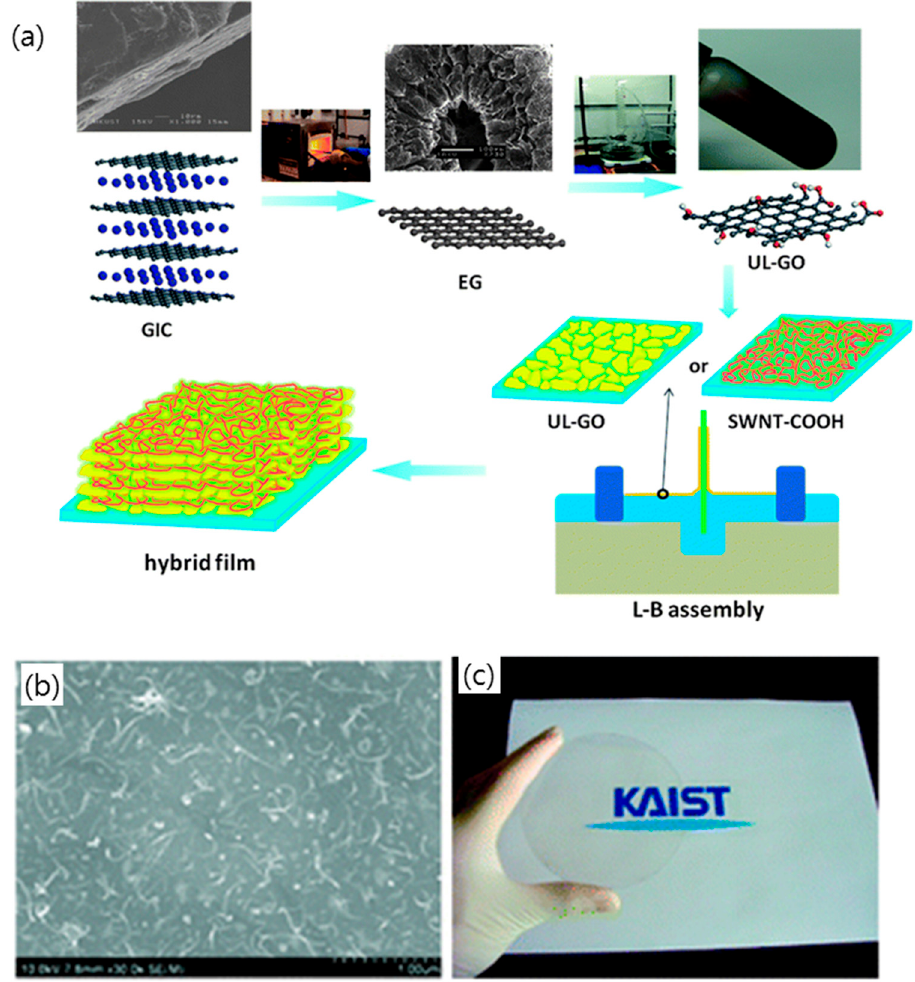
Figure 6. ( a ) Flow chart for the synthesis of ultra-large GO (UL-GO)/SWNT hybrid films using Langmuir–Blodgett (LB) assembly. Reproduced with the permission of Reference [50]. Copyright 2012, Royal Society of Chemistry. ( b ) SEM images of the graphene oxide multi-walled carbon